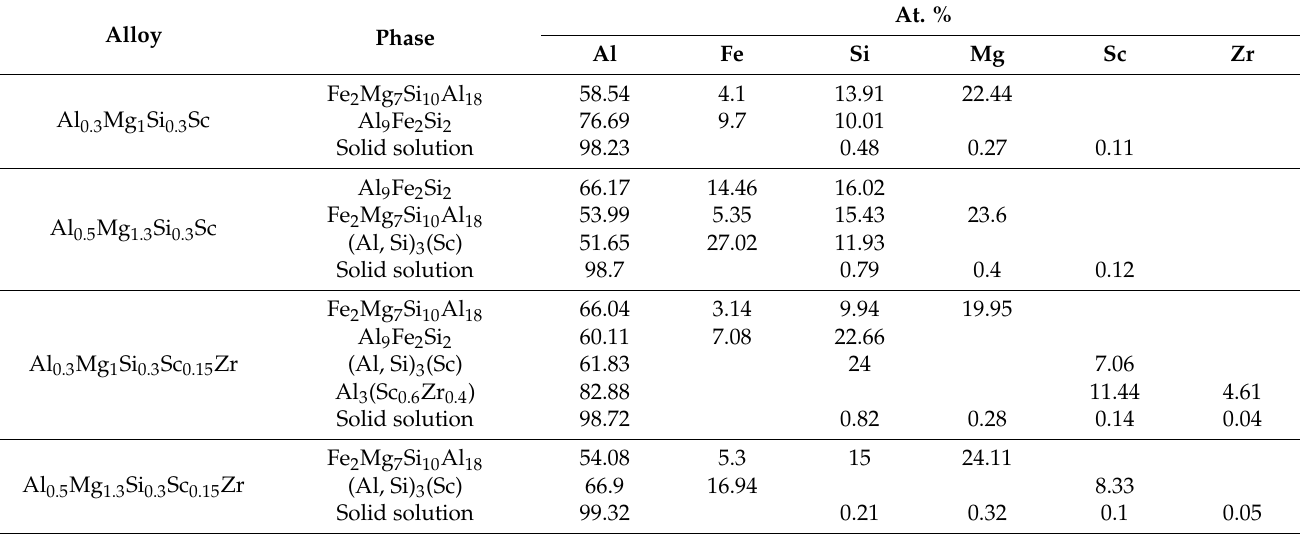
Table 4. Chemical composition of intermetallic particles in the studied